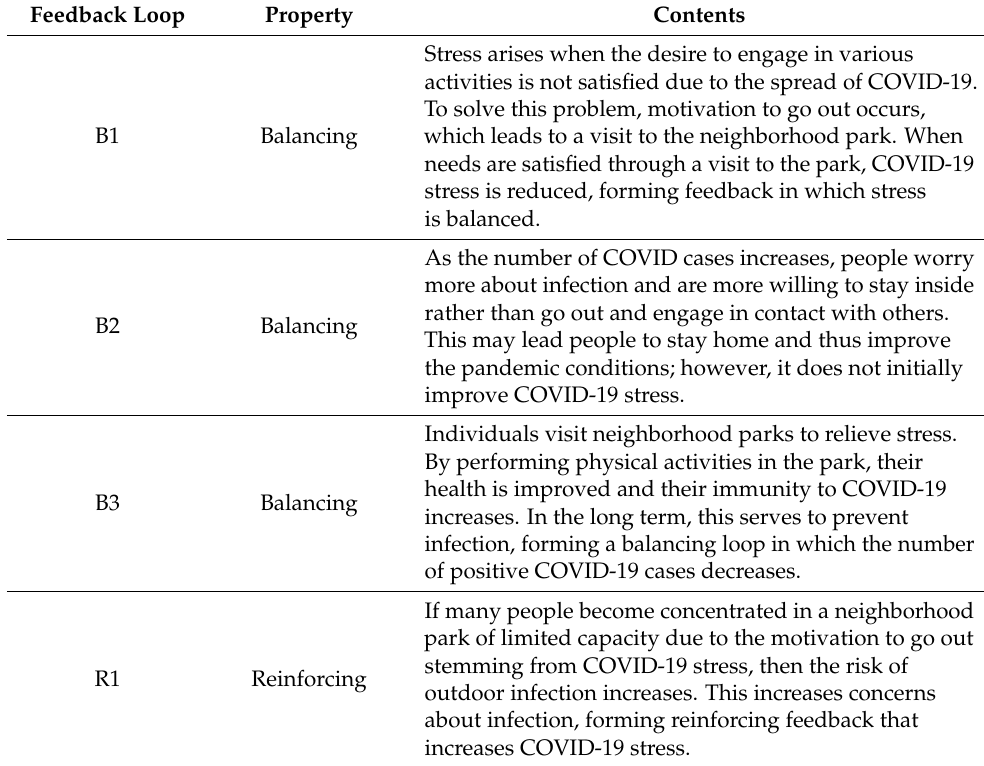
Table 2. Neighborhood park COVID-19 response feedback structure.